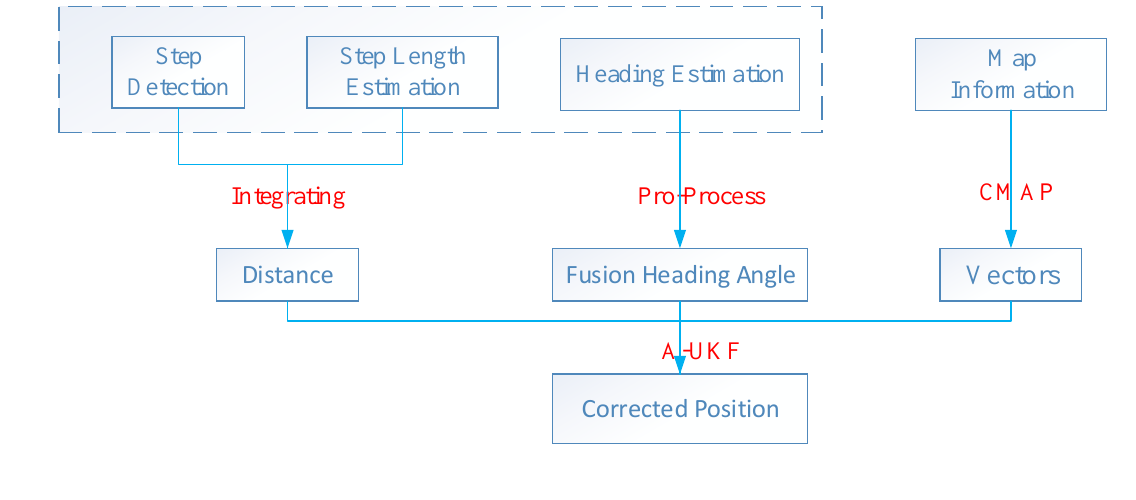
Figure 8. Flowchart of the filter process.